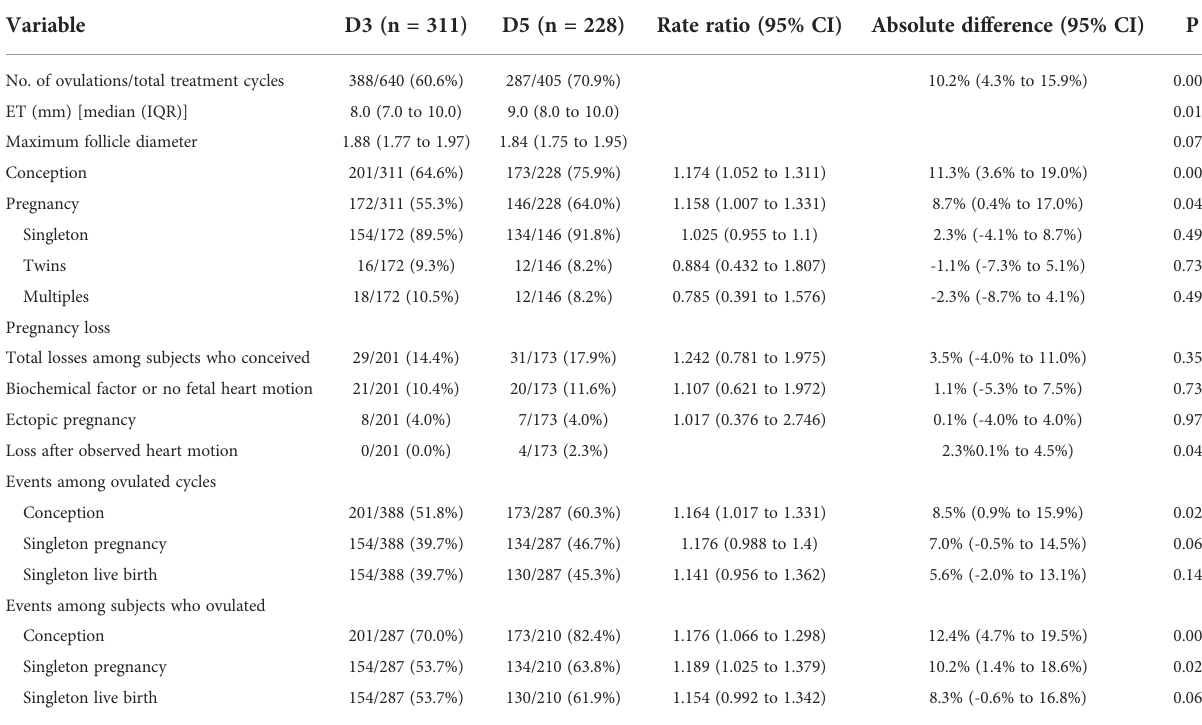
TABLE 3 Rates of Ovulation, Pregnancy, and Pregnancy